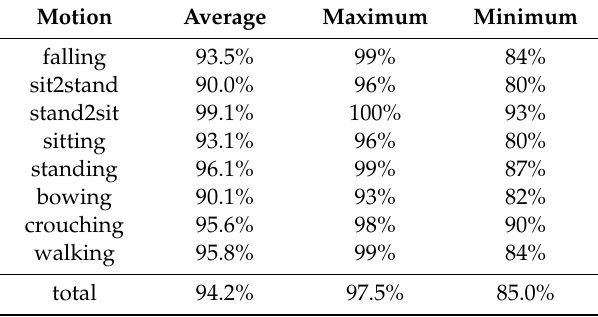
Table 5. The average, maximum and minimum correct answer rate with the 3D